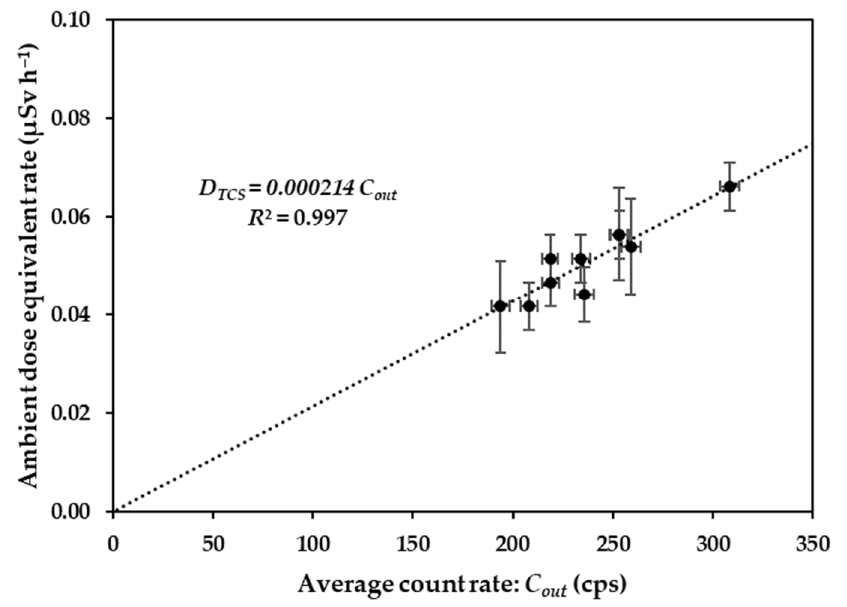
Figure 5. Relationship between the EMF spectrometer count rates calibrated with ambient dose equivalent rates obtained using the survey meter.